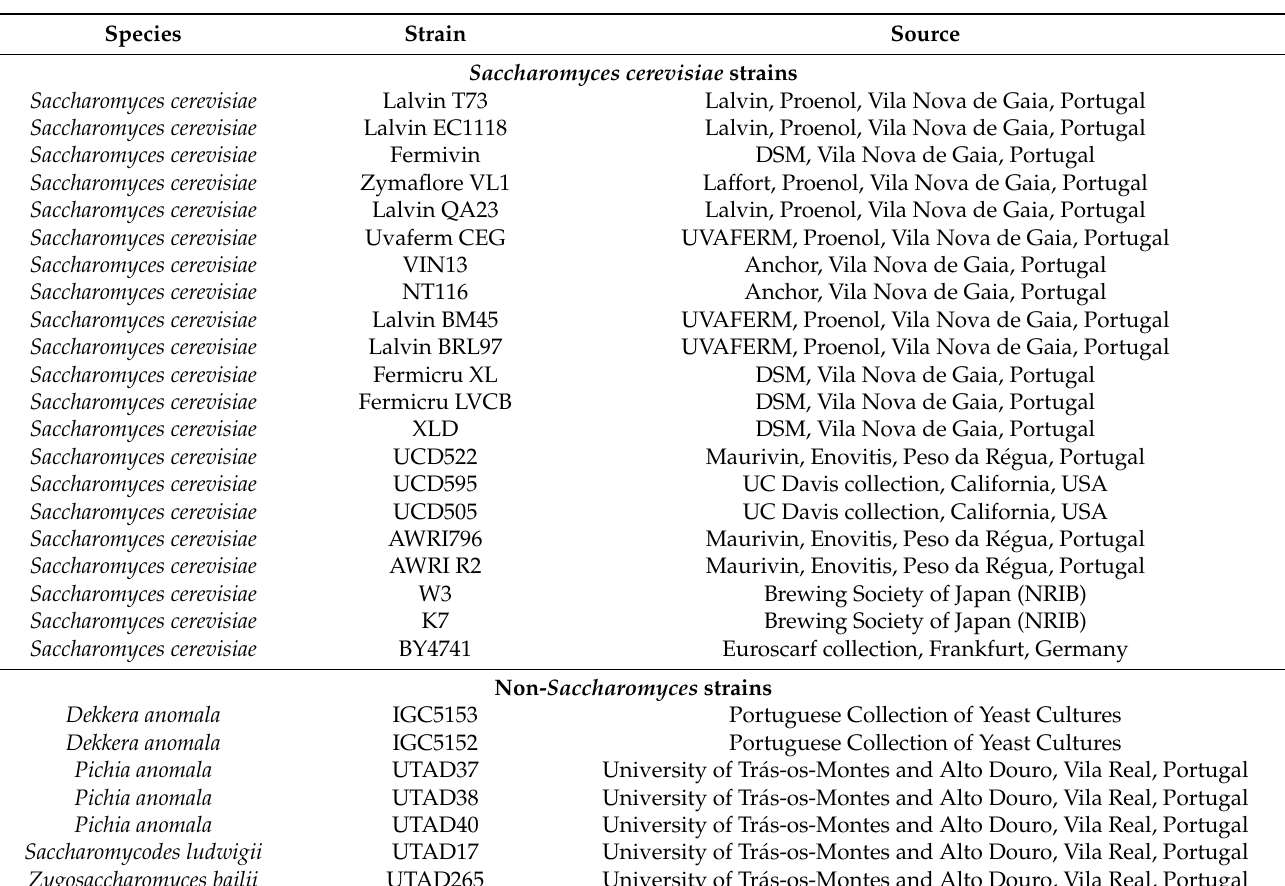
Table 1. Yeast strains used in this